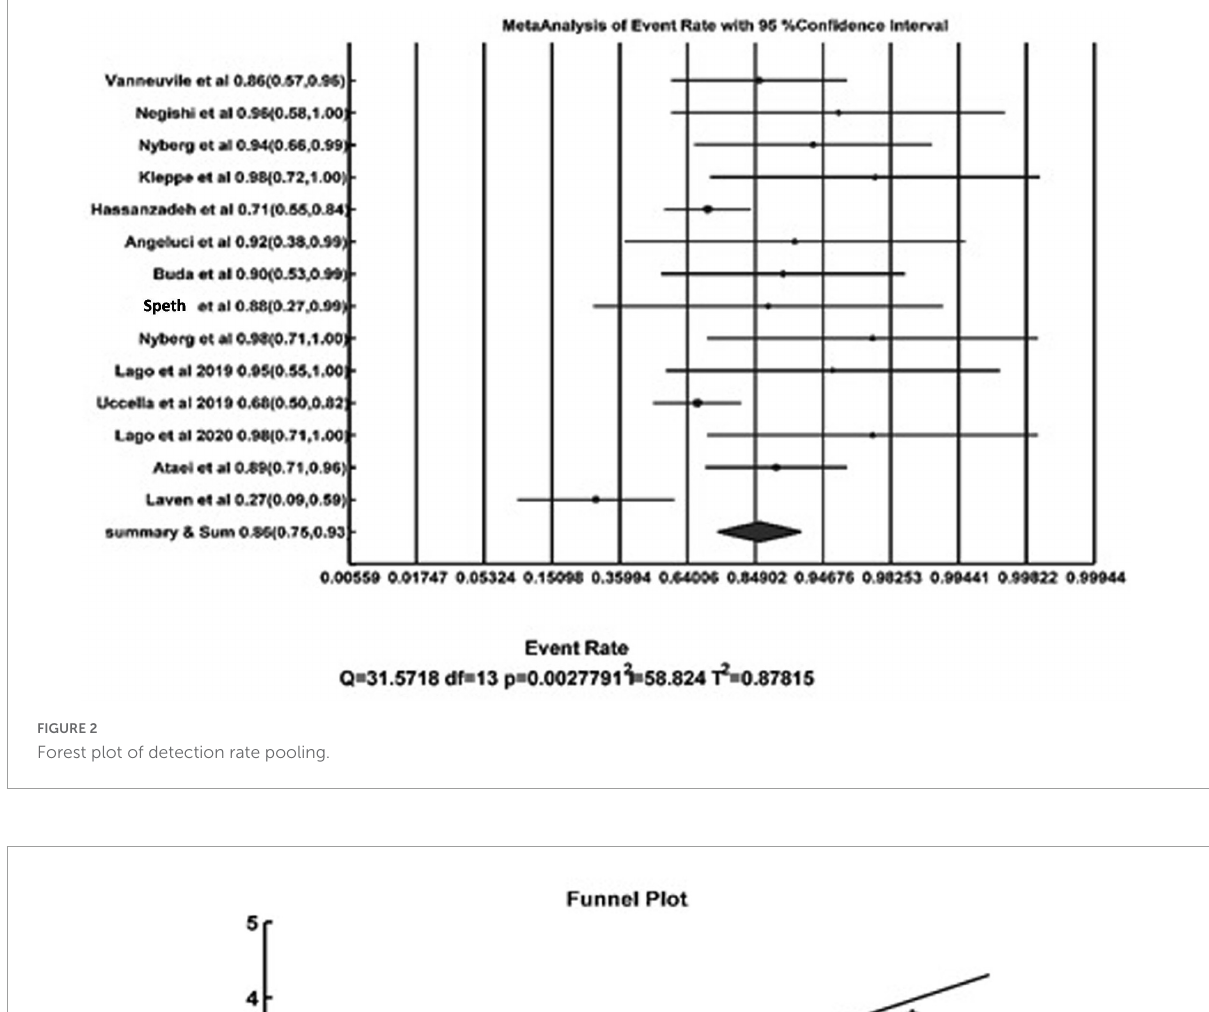
FIGURE2 Forest plot of detection rate pooling.